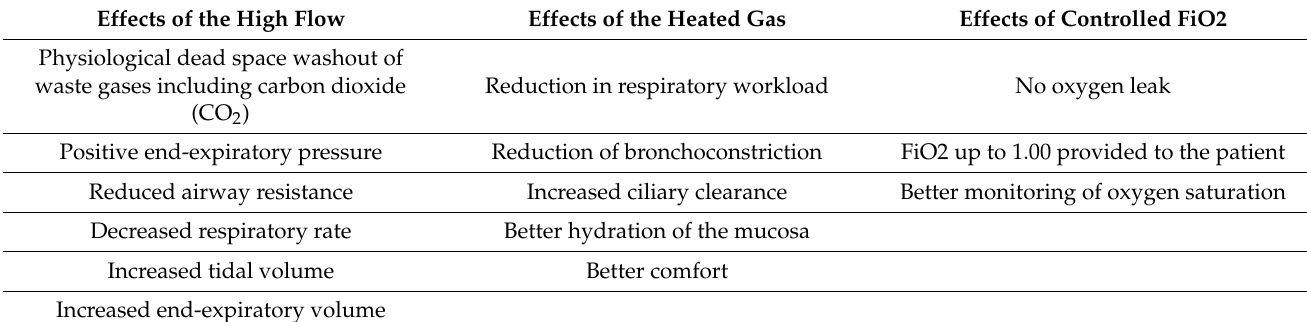
Table 1. Physiologic mechanisms responsible for the beneficial effects of high-flow nasal cannula (HFNC). Effects of the High